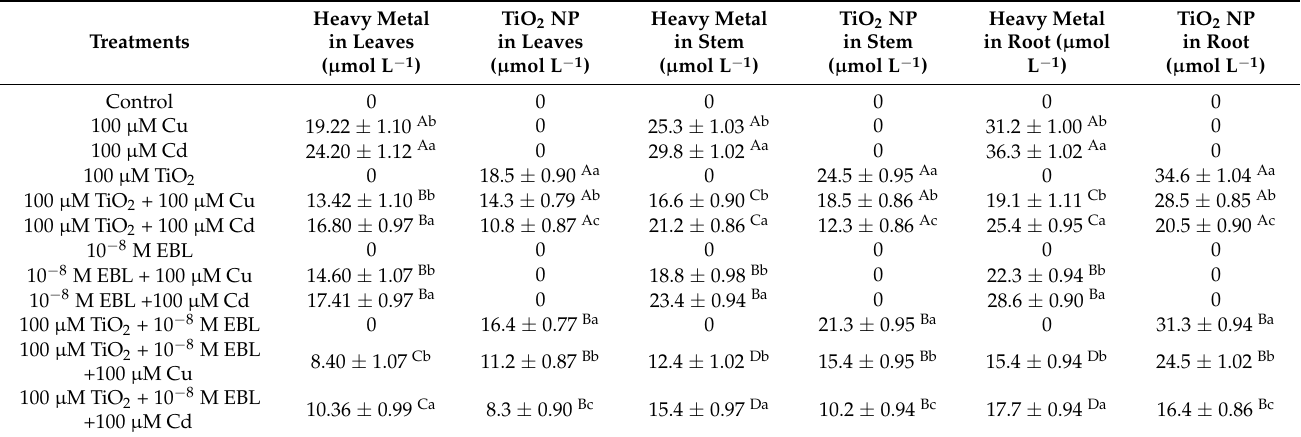
Table 3. The accumulation concentrations of titanium oxide nanoparticles and corresponding heavy metals (Cu and Cd) in bamboo shoots, stems, and